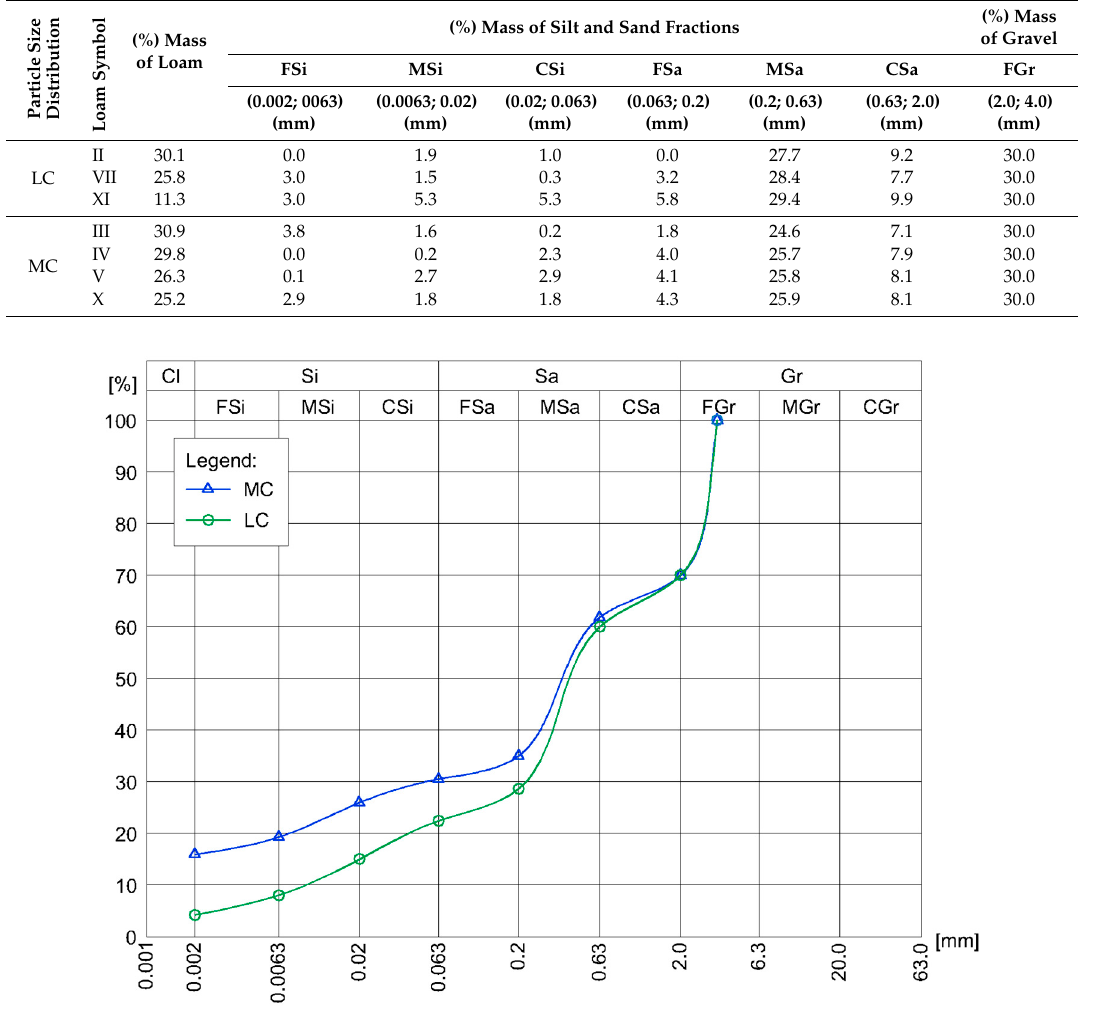
Table 2. Percentage mass compositions of each soil mixture.